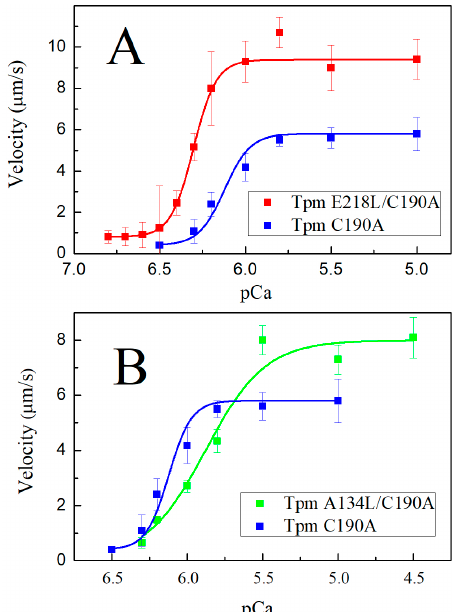
Figure 5. Ca 2 + -dependent sliding velocities of thin filaments containing E218L / C190A ( A ) and A134L / C190A ( B ) Tpm mutants in comparison with C190A Tpm obtained in the in vitro motility assay. Each data point represents the mean ± SD from three independent experiments. Data were fitted with the Hill equation as described in Material and Methods. The fitting parameters are shown in Table 2.